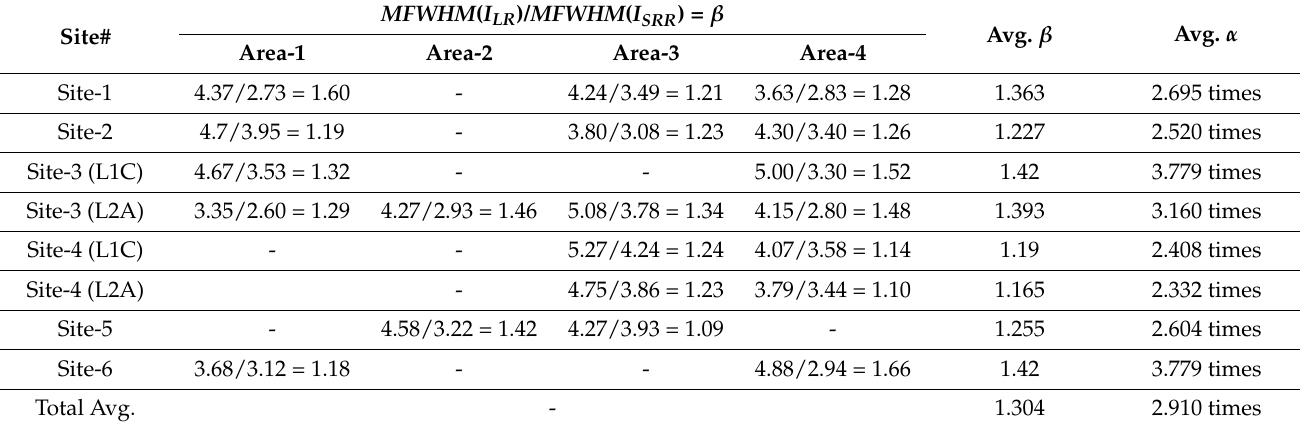
Table 4. Summary of the ELF measurements of all demonstrated examples and estimated effective resolution improve- ment